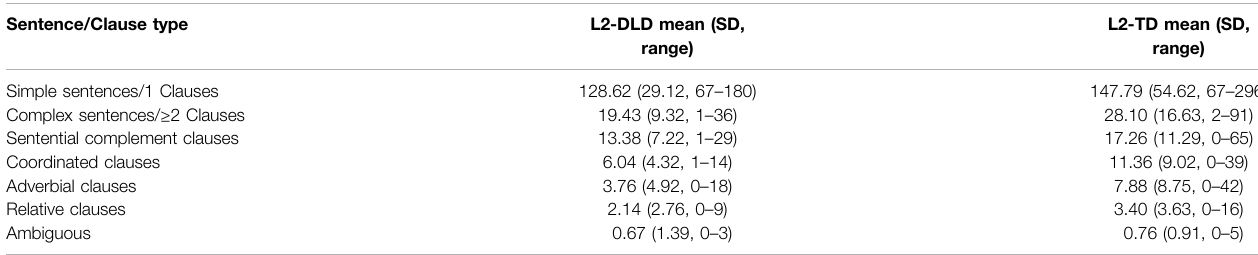
TABLE 3 | Distribution of simple and complex sentences and clause type and by